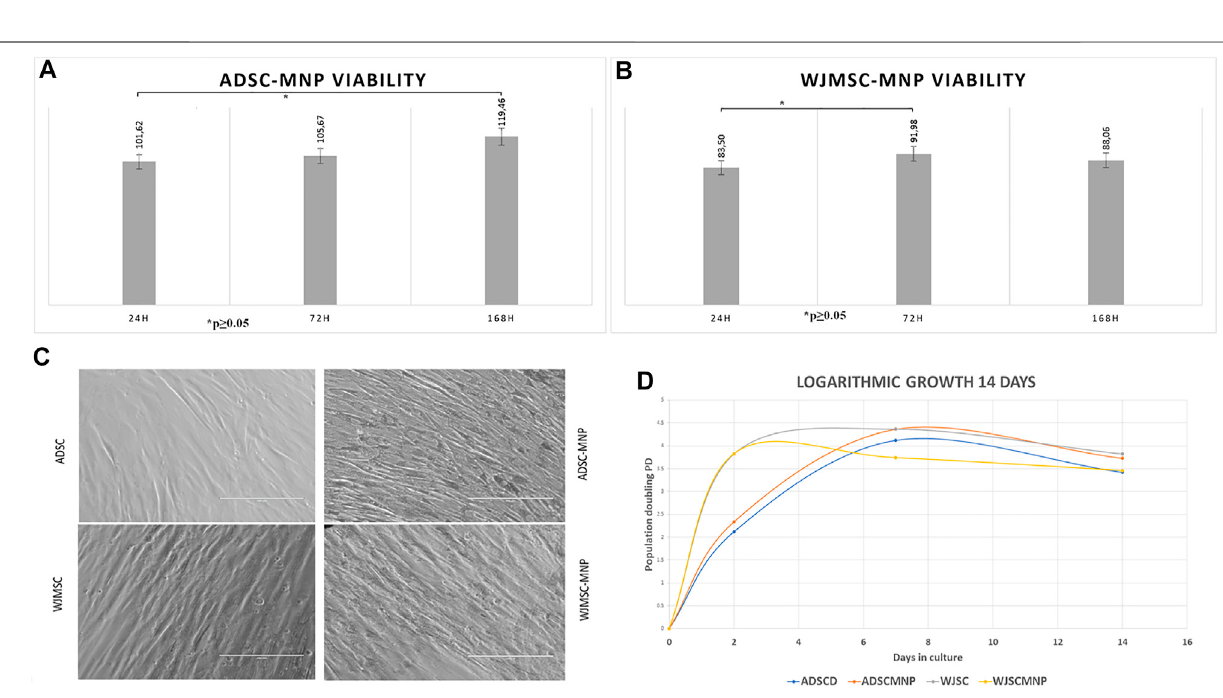
FIGURE2| Long term viability inculture MTT assayfor cells exposed to40 μ m/mlFe 3 O 4 bare MNP addedin thecell culture media; ADSC demonstrate signi fi cant increaseinMTTactivityat7 days(168 h)comparedto24 h:atalltimepointsviabilityismorethan100%ofnon-loadedcellsdemonstratinggoodoverallviabilityandlack of MNP cytotoxicity (A) WJMSC viability has a minimum at 24 h cell particle interaction increase at 72 h compared to 24 h, slightly decreases at 7 days demonstrating acceptable viability and MNP toxicity (B) ; morphological evaluation of ADSC-MNP compared to ADSC and WJMSC compared to WJMSC-MNP after 48 h cell particle interaction demonstrating maintenance ofcell shape, apparent membrane integrity and even distribution ofMNP inside cell body without penetrating nuclei with visible higher amount of incorporated MNP for ADSC-MNP than WJMSC-MNP (C) ; logarithmic growth curve of MNP loaded and non -loaded ADSC and WJMSC Cell proliferate, with lower, non-signi fi cant PD values for WJMSC-MNP and higher, non-signi fi cant PD for ADSC-MNP compared to ADSC and WJMSC up to 7 days and plateau afterwards in order to displayed a slight descendent trend at day 14 compared to day 7 most probably due to reaching con fl uence in the culture dish (D) . PD (cid:2) population